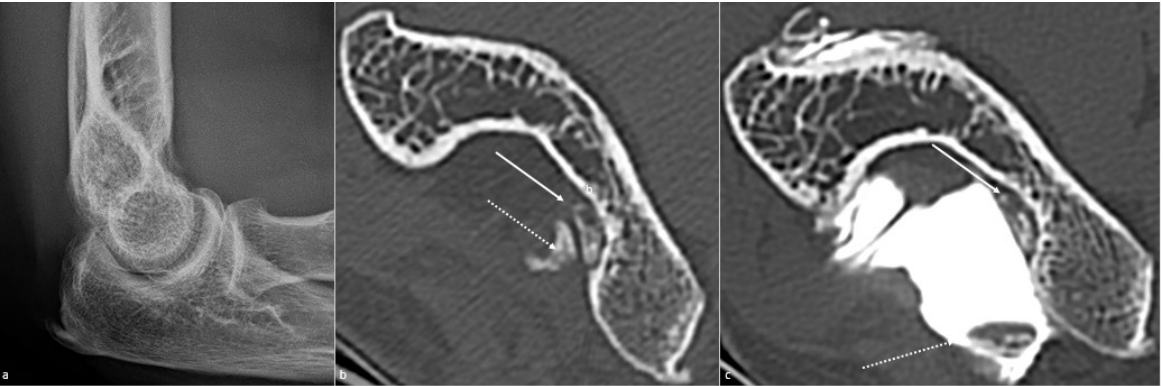
Figure 8. Articular loose bodies. Olecranon loose bodies are shown, not depicted on ( a ) a profile radiograph but well seen on ( b ) an axial CT-scan view (arrows). ( c ) CT arthrography allows identifying a free lose body (dotted white arrow) and a synovial-embedded one (white arrow), in a 57-year-old woman presenting osteoarthritis secondary to a radial head fracture. A CT and CT-arthrography checklist is presented in Table